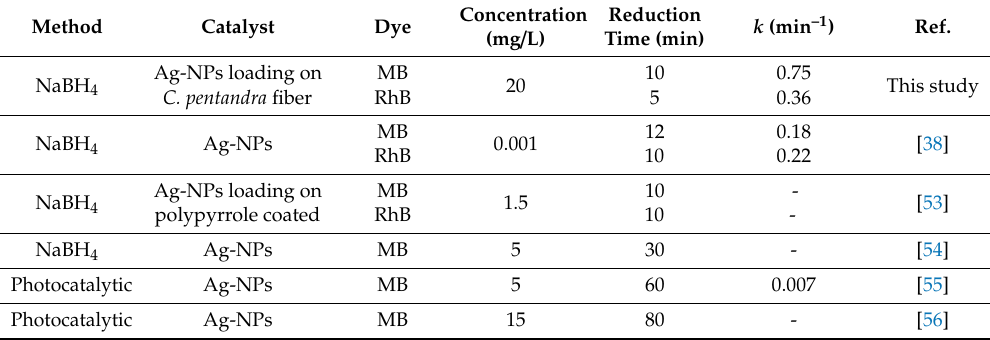
Table 5. Comparison of the catalytic reduction performance of MB and RhB dye by AgNPs nanocatalyst synthesized from another method of